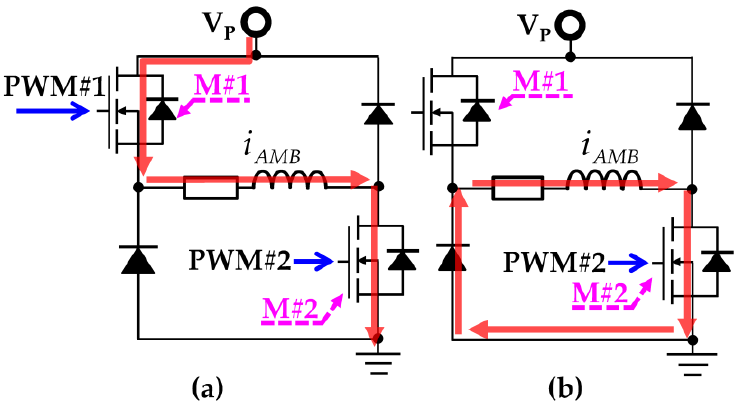
Figure 3. Operation states of DC 2 (dual cooperative drive circuit) under ADM (analog driving mode): ( a ) charge state; ( b ) discharge state.